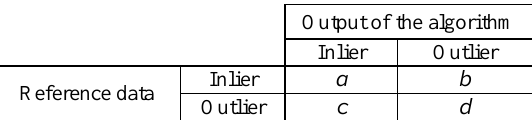
Table 2. Accuracy assessment parameters